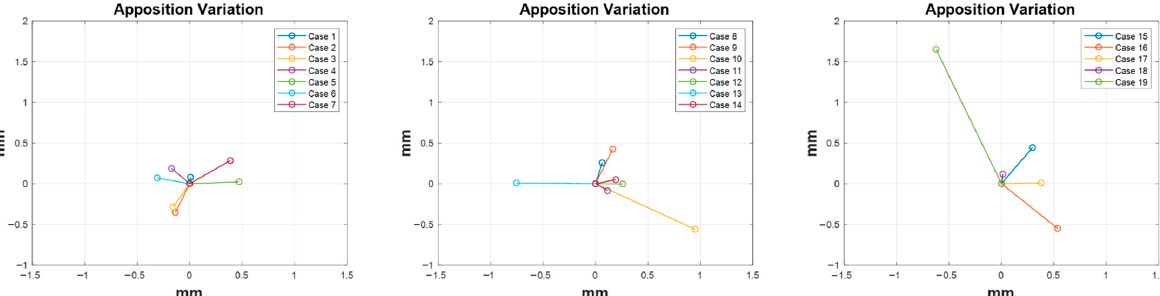
Figure 6. Apposition variation results after virtual reduction (the central position of the red triangle in Figure 3B) of the fractured bone. The central point of the deep blue triangle in Figure 3B was set at the central coordinate of the graph (X = 0, Y = 0). Left: Cases 1 to 7; middle: Cases 8 to 14; and right: Cases 15 to 19.